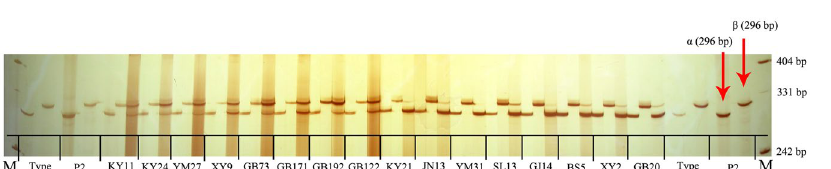
Figure 4. Polyacrylamide gel electrophoresis showing evidence of heteroplasmy with both the “ α ” and “ β ” type COX1 sequences amplified under different conditions and with different primers. Bottom symbols represented the names of tested strains (type = type specimen). Except the P2 sample and the reference type sequences that had two lanes each to the left and right sides of the gel, the remaining isolates each had three lanes where the left lane represented the “ α ” COX1 amplicon (296 bp) using the “ α ” specific primer pair under 45 PCR cycles, the middle lane represented the “ β ” COX1 amplicon (312 bp) using the “ β ” specific primer pair under 45 PCR cycles, and the third lane contained both amplicons (but in different proportions) using both primer pairs under 45 PCR cycles. Marker: puc19 DNA/MspI, only bands 404, 331 and 242 bp were shown in the